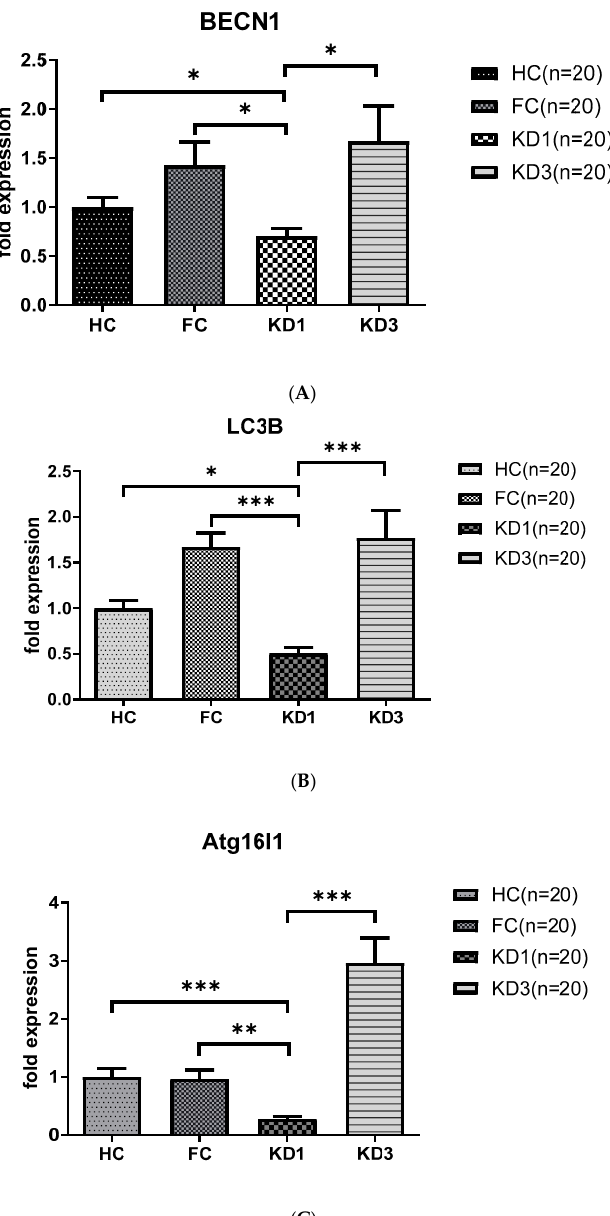
Figure 1. Analyses of mRNA autophagy markers in the peripheral white blood cells of Kawasaki disease (KD) patients before and after IVIG treatment. Total RNA from the peripheral white blood cells of healthy controls (HC, n = 20), febrile controls (FC, n = 20) and KD patients before (KD1, n = 20)